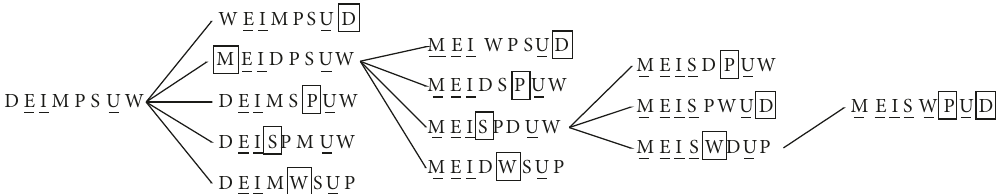
Figure 5: Path relinking shown on a tour of eight attractions. Underlined nodes signify agreement between the two original parent tours. Boxed nodes signify nodes that are in the correct spot due to the swap performed during that step.